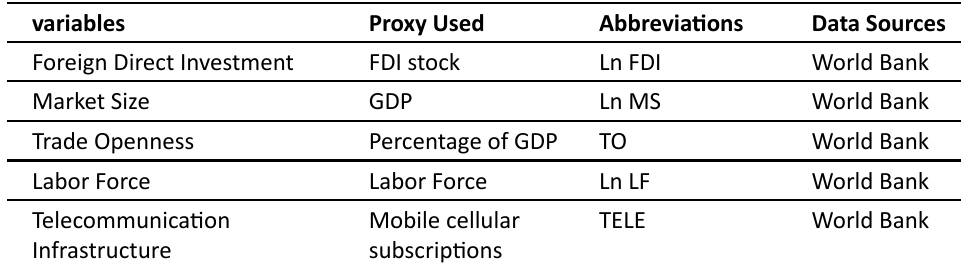
Table 1: Variables Description, Symbols, Data Sources